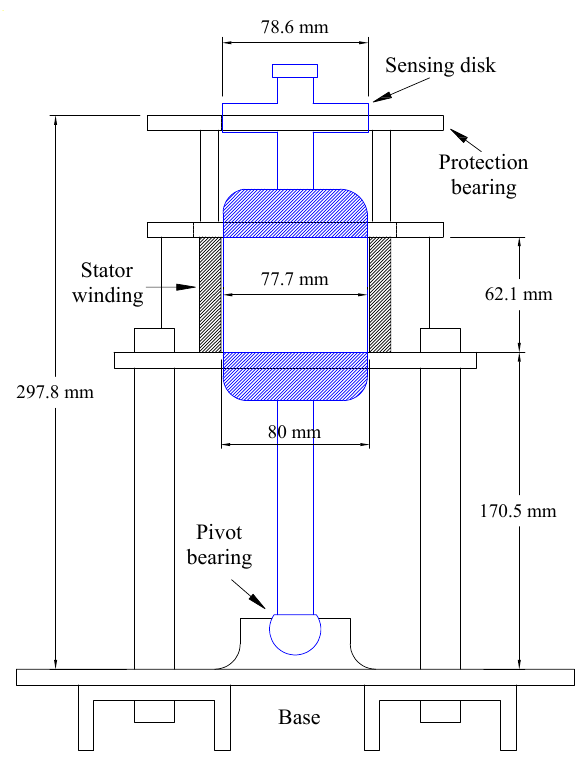
Figure 8. The cross-section view of the bearingless